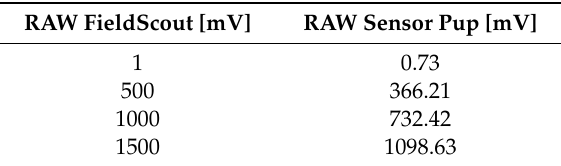
Table 3. Results of the A / D